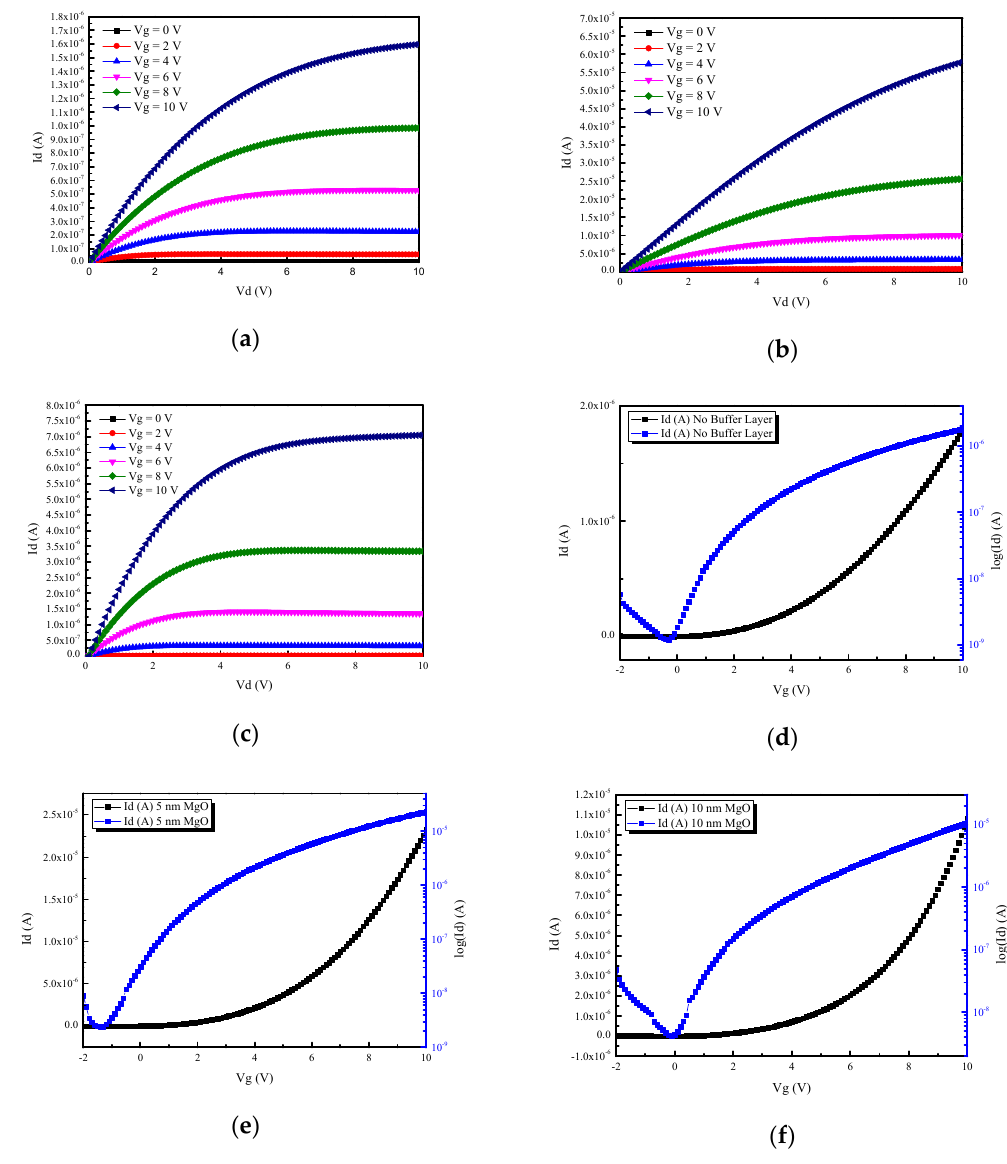
Figure 8. Output characteristics of MIO TFTs ( a ) without buffer layer, ( b ) with 5 nm buffer layer, and ( c ) 10 nm buffer layer, and transfer characteristics of MIO TFTs ( d ) without buffer layer, ( e ) with a 5 nm MgO buffer layer, and ( f ) with a 10 nm MgO buffer layer. Table 3. Transfer characteristics of MIO TFTs with and without MgO buffer layer.